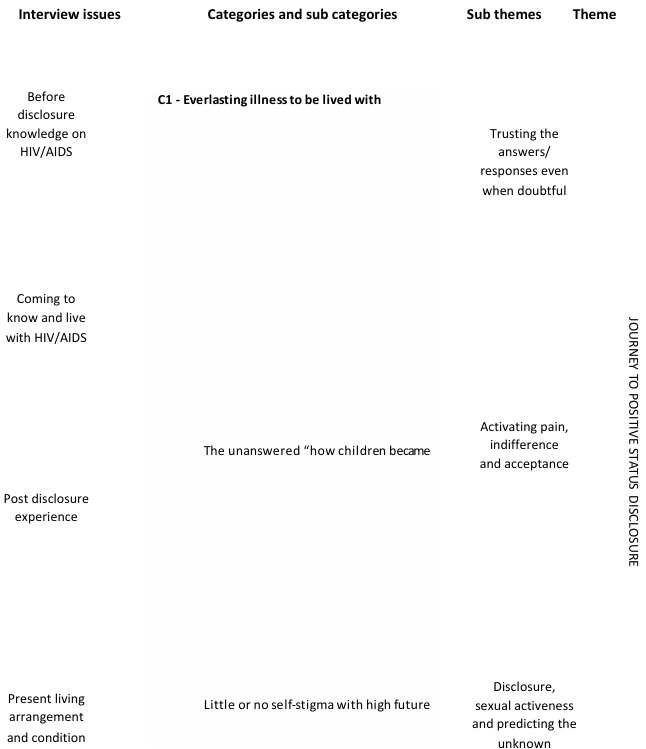
Figure 2. Child/adolescent disclosure pathway context.